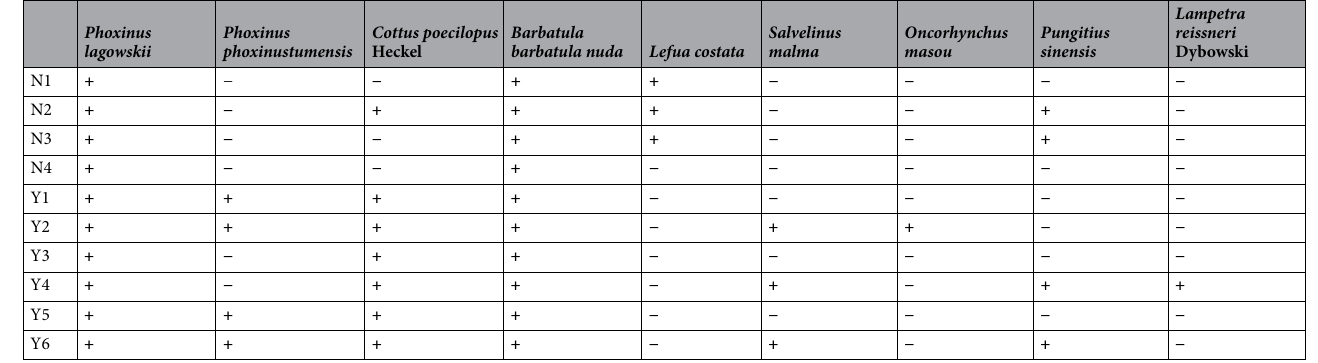
Table 1. The fish species were found in the Hunchun River Basin. N i , stream without otter; Y i , stream with otter; + / − , presence/absence of fish species.